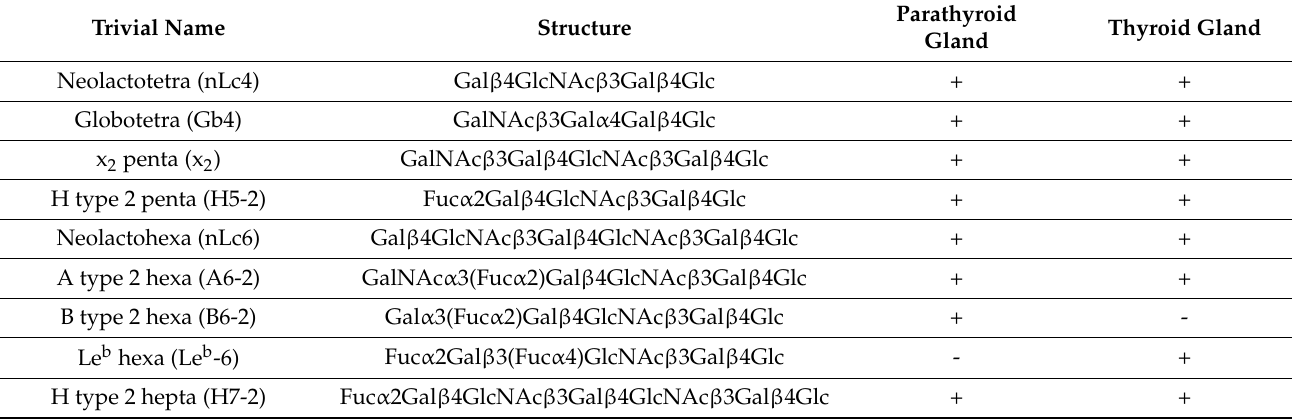
Figure 6. Summary of oligosaccharides derived from the non-acid glycosphingolipids from human thyroid and parathyroid glands. The proposed structures are depicted using the Symbol Nomencla- ture for Glycomics (SNFG) [12,13]. Table 2. Glycosphingolipid-derived oligosaccharides from the total non-acid fractions identified by